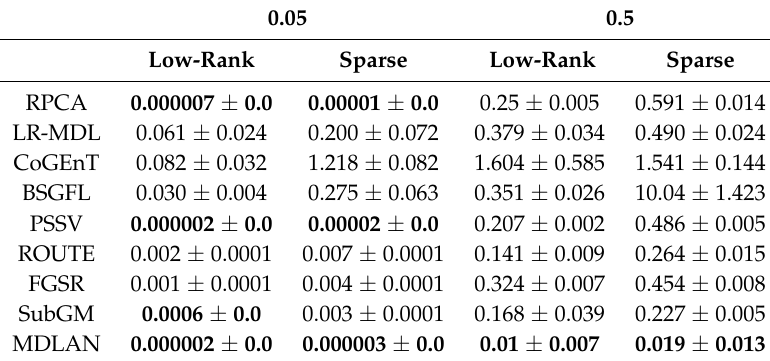
Table 1. Quantitative comparison of NRMSE for the low-rank and sparse noise matrices. LR-MDL: low-rank minimum description length; CoGEnT: conditional gradient with enhancement and truncation; BSGFL: generalized fused lasso foreground modeling; PSSV: partial sum of singular values; ROUTE: low-rank matrix recovery via robust outlier estimation; FGSR: factor group-sparse regularization; SubGM: subgradient